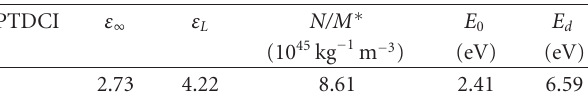
Figure 5: Refractive index and extinction coe ffi cient of the PTDCI film. Table 2: Dispersion parameters of the PTDCI